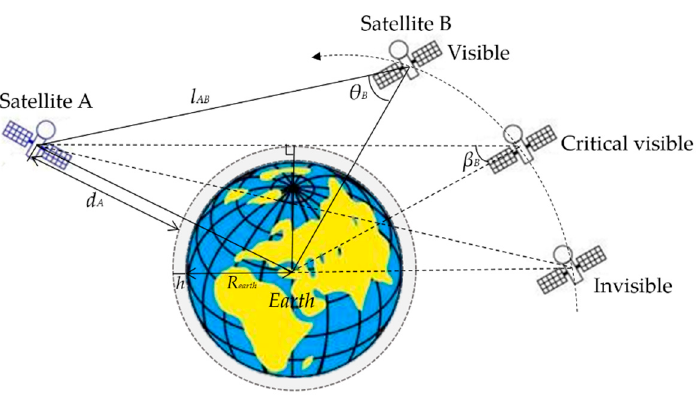
Figure 4. Geometric visibility between satellites.